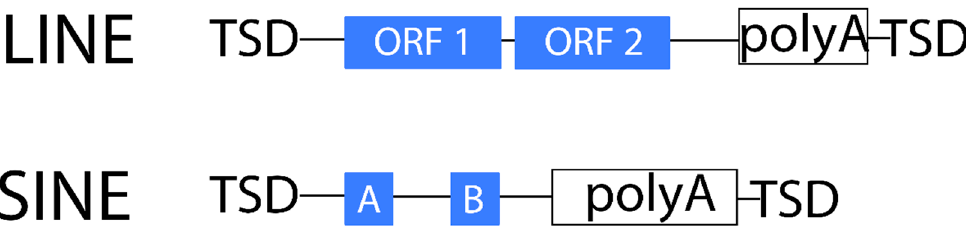
Figure 3. Structure of non-LTR retrotransposons.